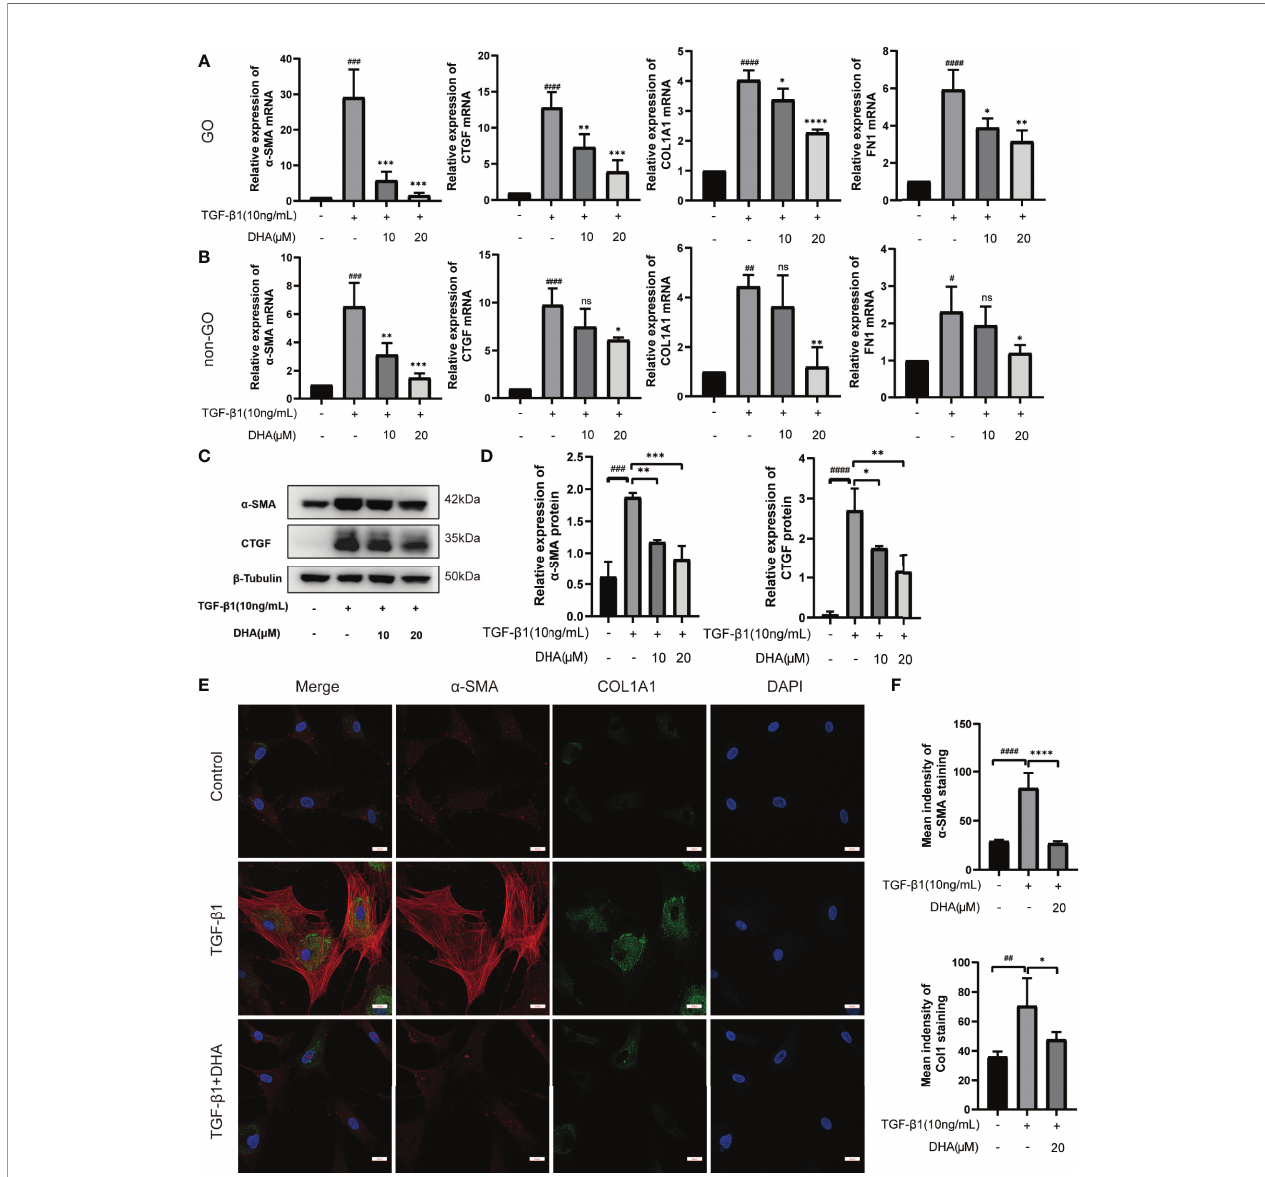
FIGURE 2 | DHA exerts anti fi brotic effects on OFs. (A, B) The mRNA levels of a -SMA, CTGF, COL1A1, and FN1 in GO and non-GO OFs (n = 3). (C) The protein expression levels of a -SMA and CTGF were determined using western blot analysis (n = 3). (D) The densities of a -SMA and CTGF protein bands were quanti fi ed and normalized to b -Tubulin. (E) Representative images of a -SMA and COL1A1 immunostaining in GO OFs treated with TGF- b 1 (10 ng/mL, 48 h) with or without pretreatment of DHA (20 m M, 3 h). The cells were observed using a confocal microscope. Scale bars = 25 m m. Red: a -SMA, Green: COL1A1, Blue: DAPI. (F) Quanti fi cation of mean idensity of a -SMA and COL1A1. For (A, B, D, F) , the summarized data are reported as the mean ± standard error of the mean. # P < 0.05, ## P < 0.01, ### P < 0.001, #### P <0.0001 compared with the control; *P < 0.05, **P < 0.01, ***P < 0.001, ****P < 0.0001 compared with TGF- b 1 alone. ns denotes no statistical signi fi cance versus the control/TGF- b